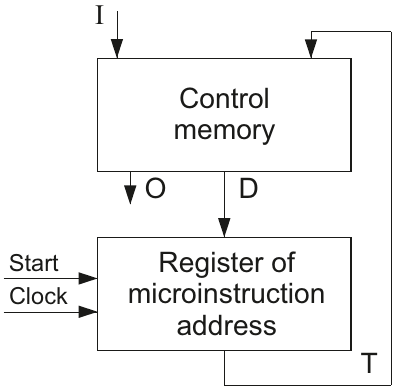
Figure 3. Trivial implementation of microprogram control